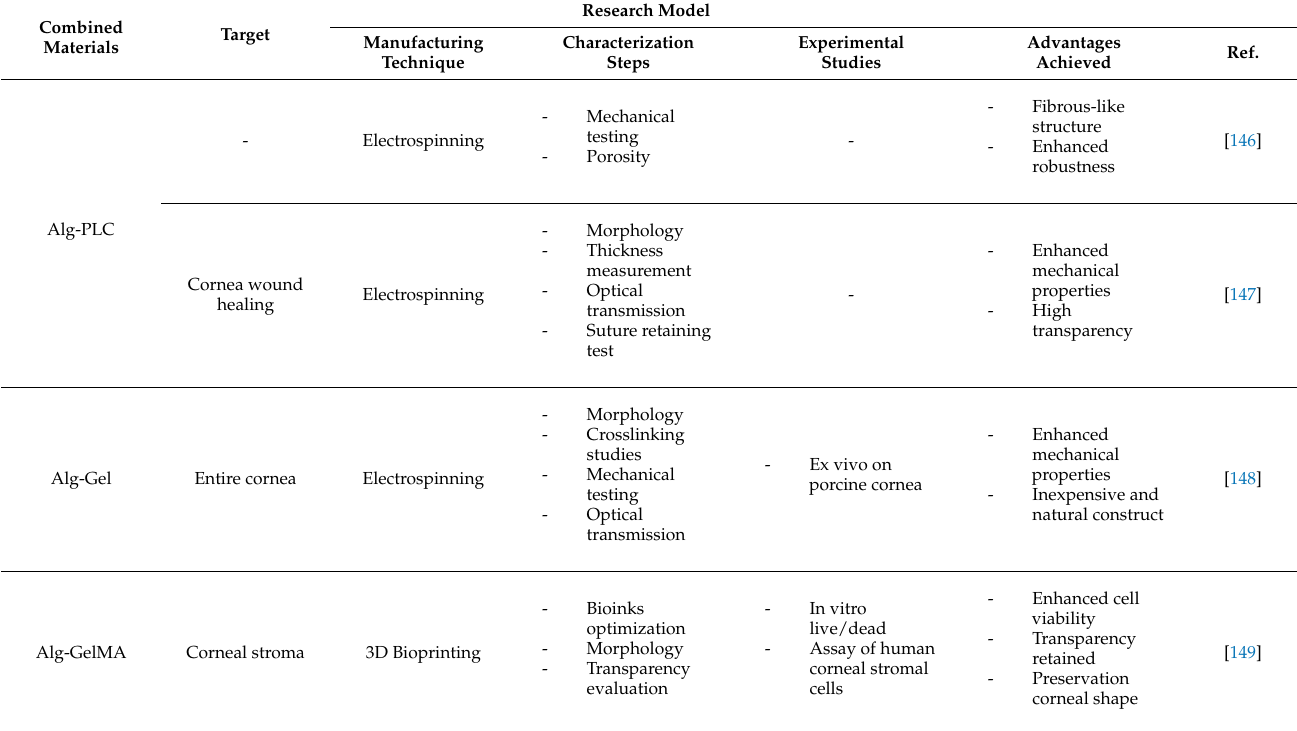
Table 1. Summary of the main properties of alginate conjugates, techniques employed in their manufacture and related advantages for corneal tissue